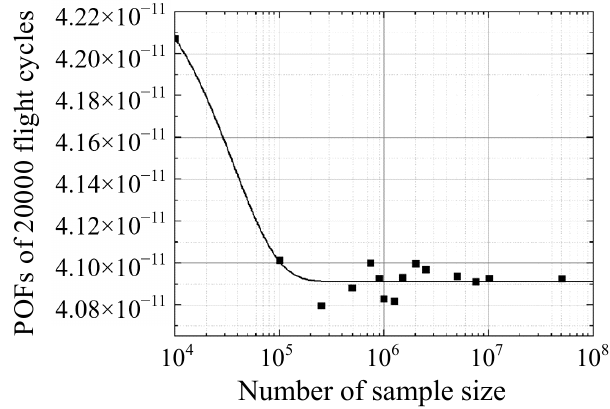
Figure 11 . POFs of cases applying MCS.